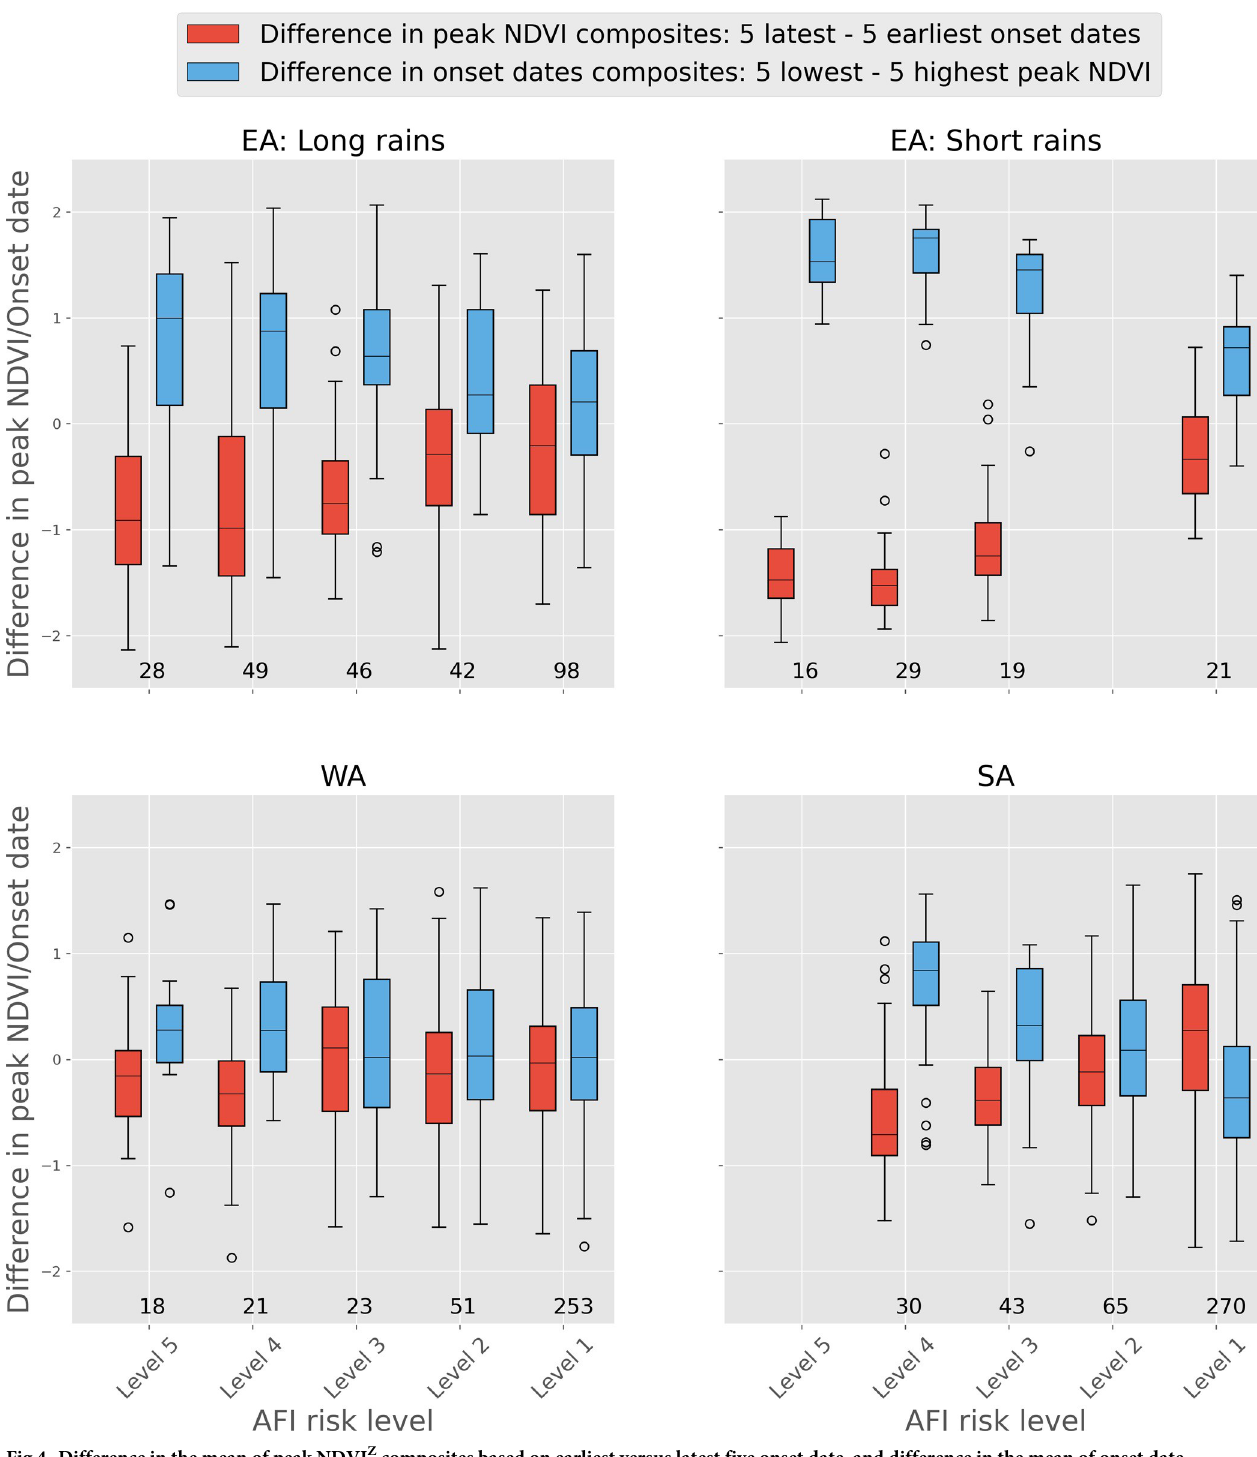
Fig 4. Difference in the mean of peak NDVI Z composites based on earliest versus latest five onset date, and difference in the mean of onset date composites based on lowest versus highest five peak NDVI values, binned based on AFI risk level.